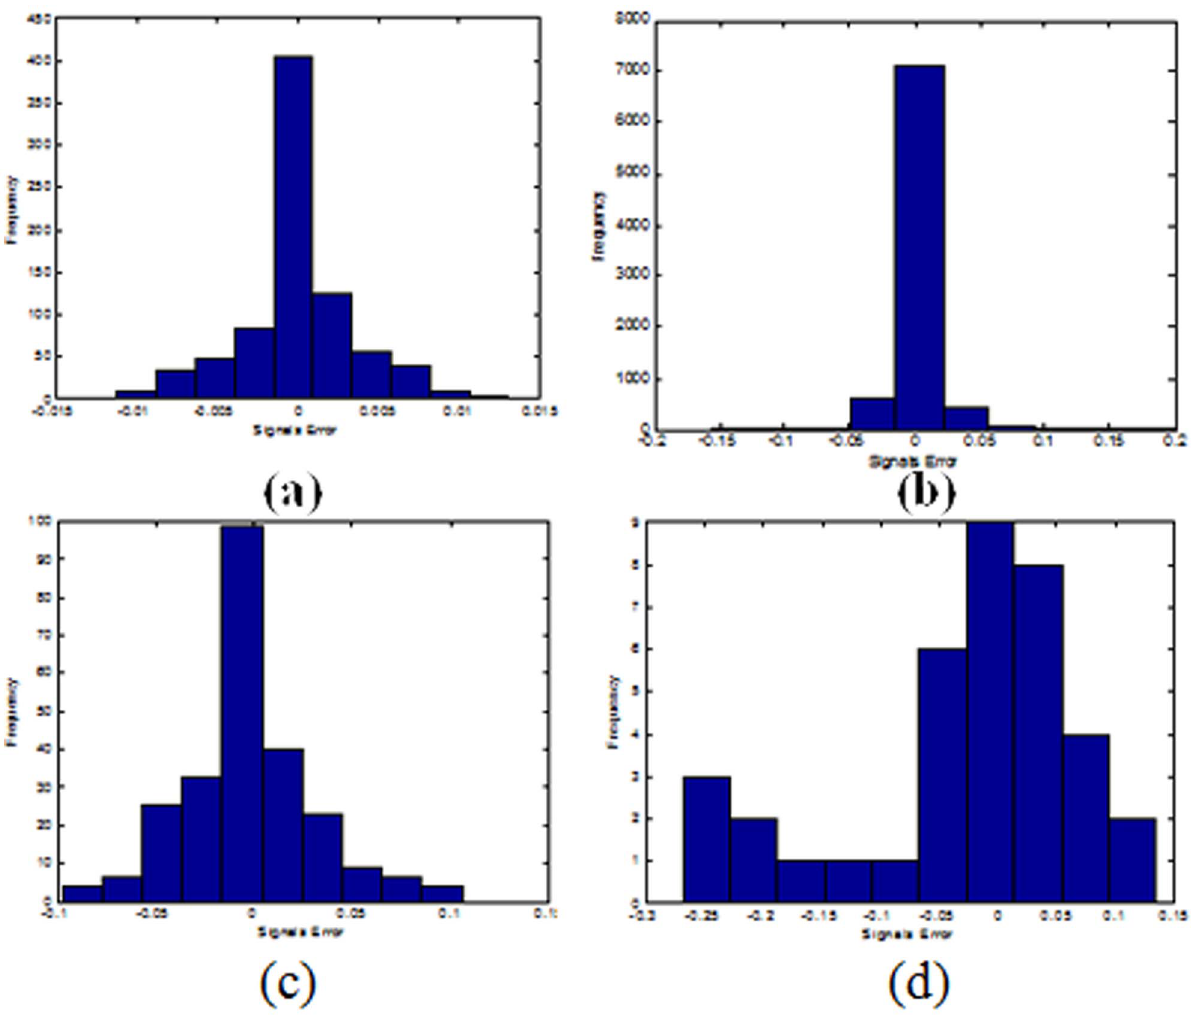
Figure 11. The histogram of the prediction error for (a) the Lorenz attractor time series; (b) the mean value of the AE index time series (c) sunspot number time series (d) heat wave temperature time series using the DRPNN.